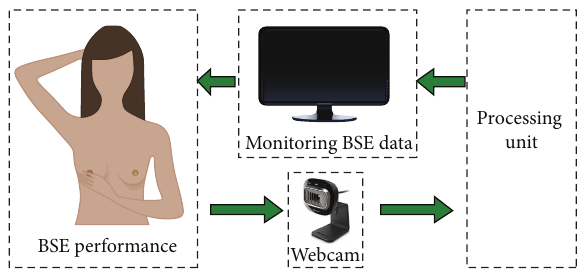
Figure 1: Intelligent computer vision-based breast self-examination (ICBSE).